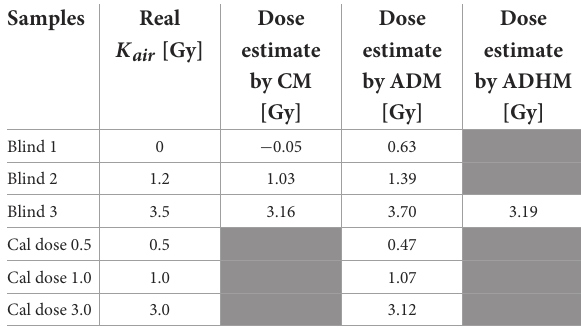
TABLE 1 Comparison of the reconstructed doses using calibration method (CM), added dose method (ADM) and added dose&heating method